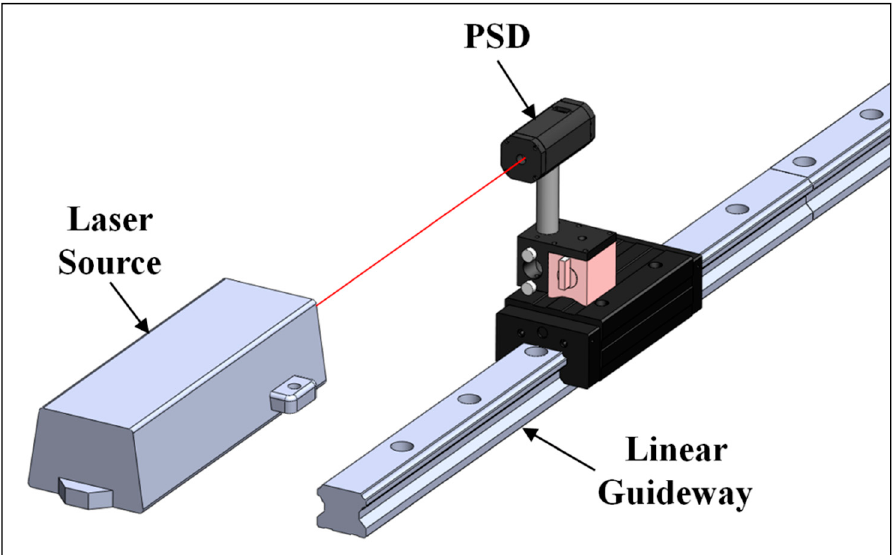
Figure 4. Schematic diagram of the straightness module.